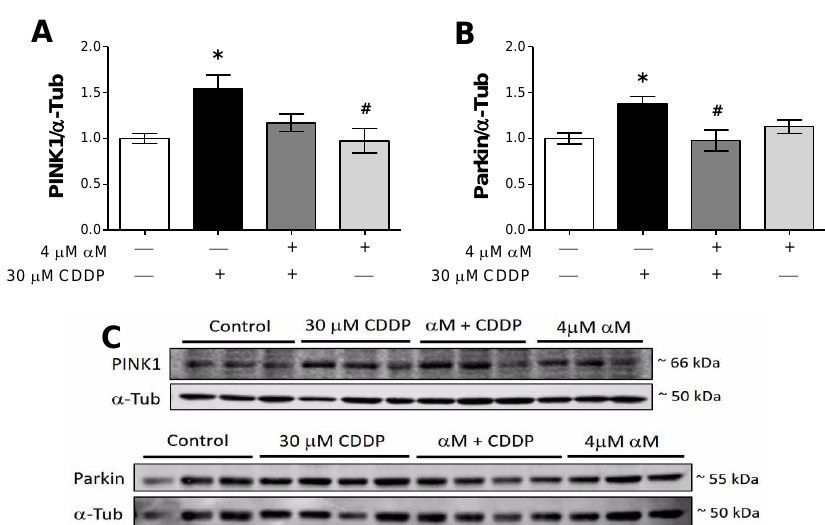
Figure 8. Modulation of mitophagy induction in LLC-PK1 cells treated with α M, CDDP or both. After 24 h of α M-, CDDP-treatment or both, mitophagy proteins ( A ) phosphatase and tensin homologue (PTEN)-induced kinase 1 (PINK1) and ( B ) parkin RBR E3 ubiquitin protein ligase (Parkin) were evaluated. Representative blots are shown in ( C ). The data are presented as mean ± SD, n = 6–7. * p < 0.05 vs. control. # p < 0.05 vs. CDDP. α -Tub = alpha-tubulin.